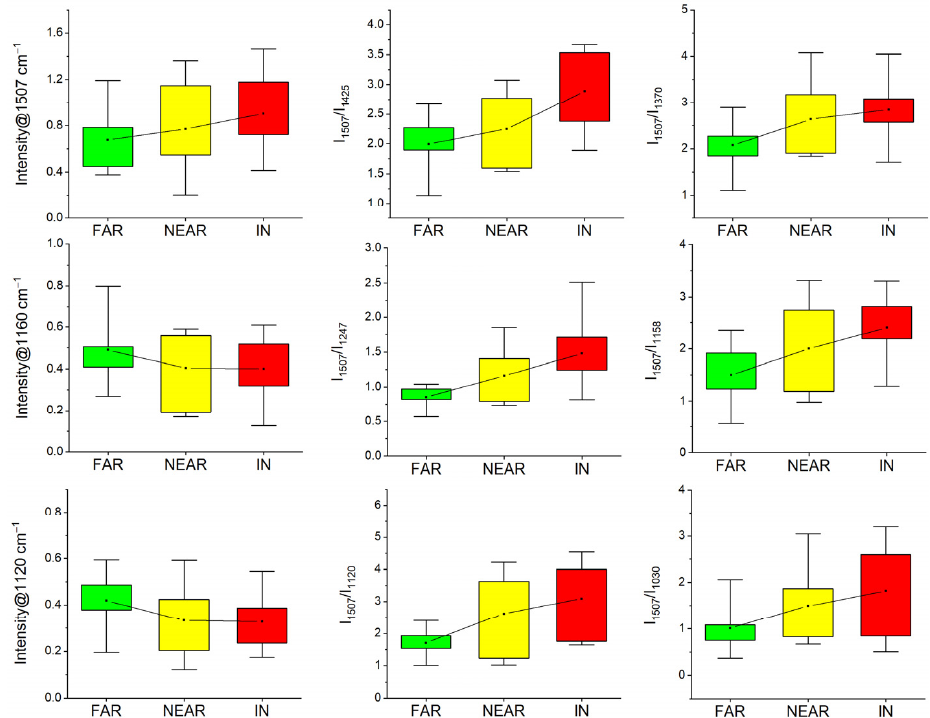
Figure 2. Boxplots of FTIR data showing band intensity variations of lignin and cellulose, along with their ratios, in the three main data acquisition location types (“FAR”—green boxplot, “NEAR”—yellow boxplot and “IN”—red boxplot locations). The box represents data within the first and the third quartile, dot symbol represents the mean value, lines extending parallel from the box are the whiskers in the 10–90 range.